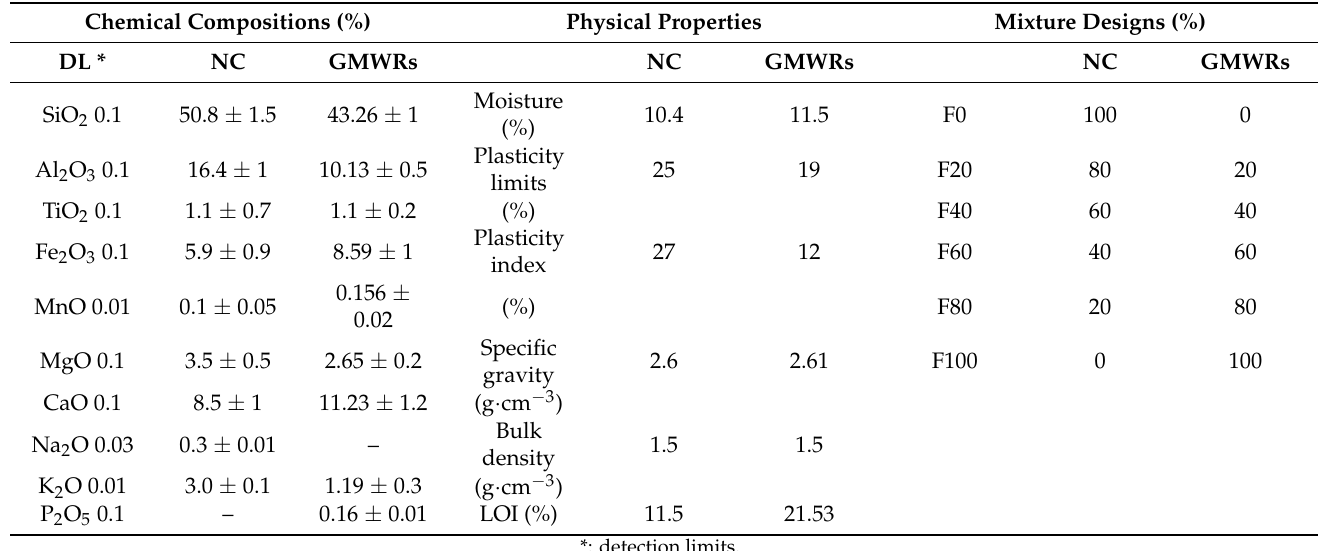
Table 1. Physico-chemical properties of the raw materials.